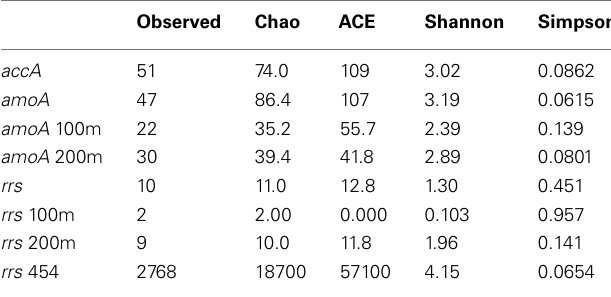
TableA4 | Diversity indices for sequenced clones obtained from Station D5 calculated using mothur (v. 1.21.1; Schloss et al., 2009).